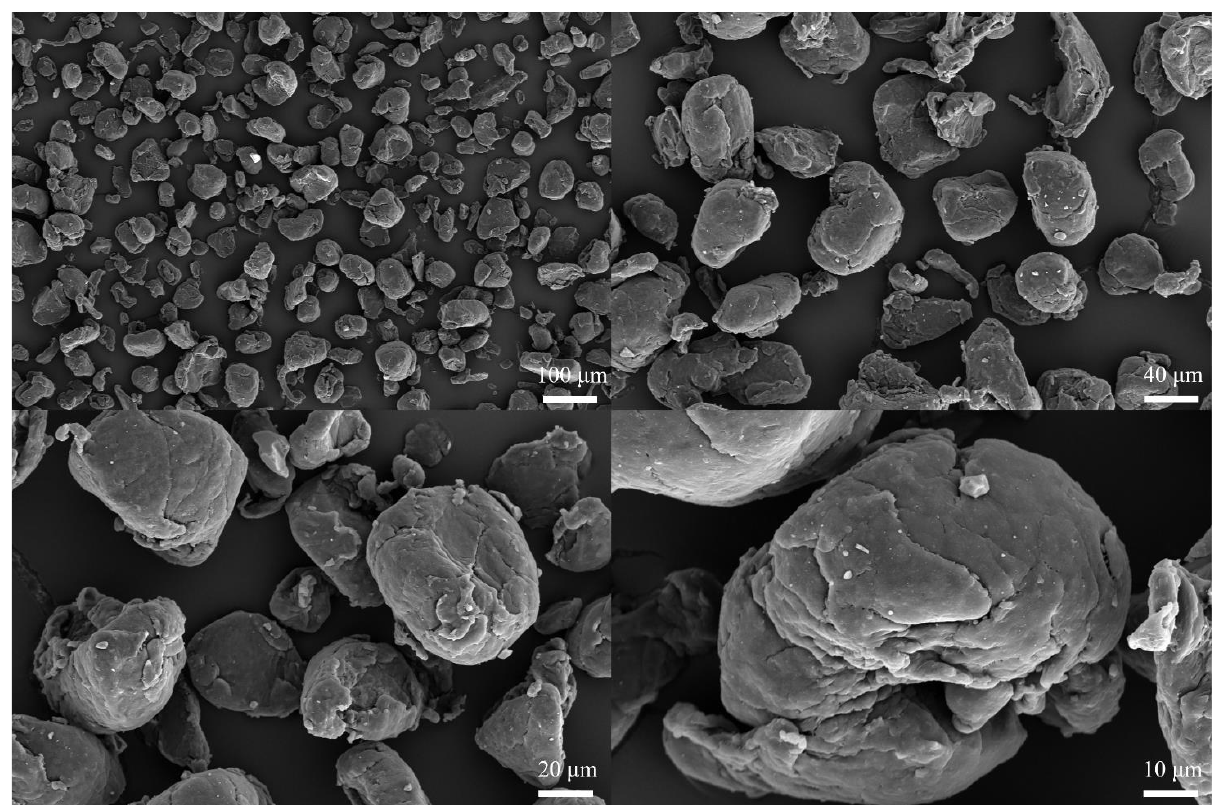
Figure 2. Scanning electron micrographs of the applied polypropylene powder.